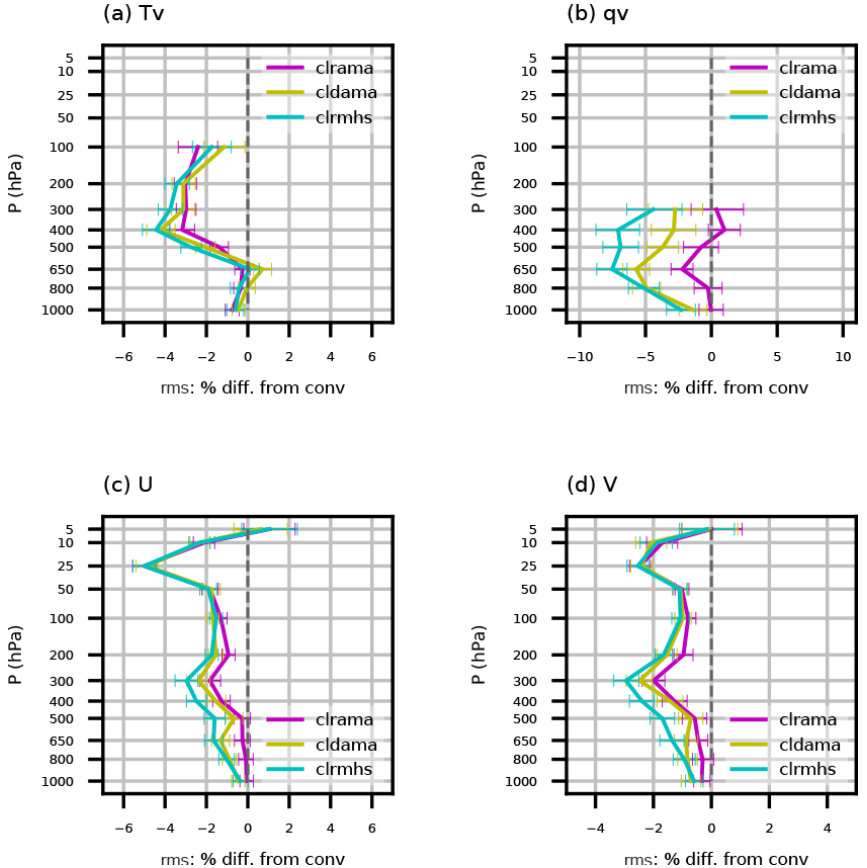
Figure 3. Vertical distributions of relative rms reduction of OMB for radiosondes’ (a) virtual temperature, (b) specific humidity, (c) zonal wind, and (d) meridional wind. Statistics are computed over the period from 00:00UTC, 18 April, to 18:00UTC, 14 May 2018, for the three radiance DA experiments against the conv experiment. A negative percentage indicates the positive impact from radiance DA experiments relative to the non-radiance DA